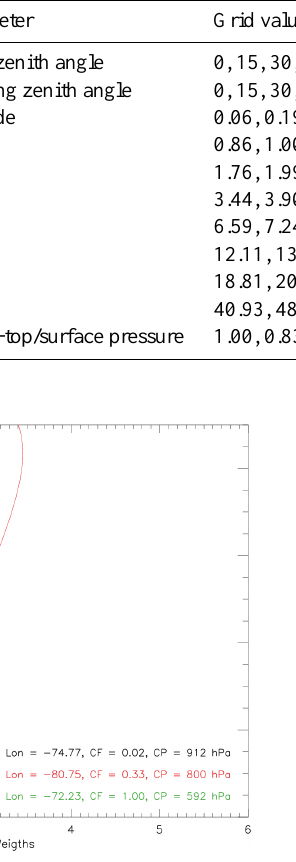
Figure 5. Example of calculated scattering weights for three pixels with different cloud fractions corresponding to the profiles plotted in Fig. 3. For cloud fractions equal to 1 the scattering weights be- low the cloud-top pressure become 0 (green line), while for other values there is a contribution below the cloud in the air mass factor calculation (red and black lines) proportional to the radiative cloud